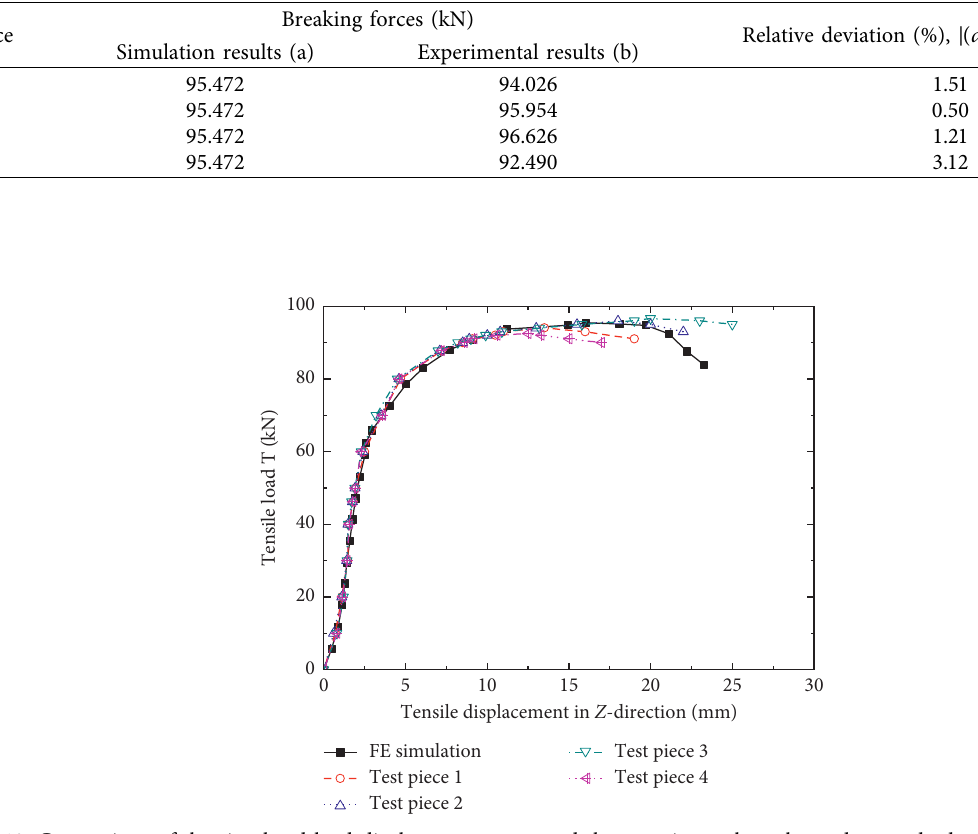
Figure 13: Comparison of the simulated load-displacement curve and the experimental results under standard crimping